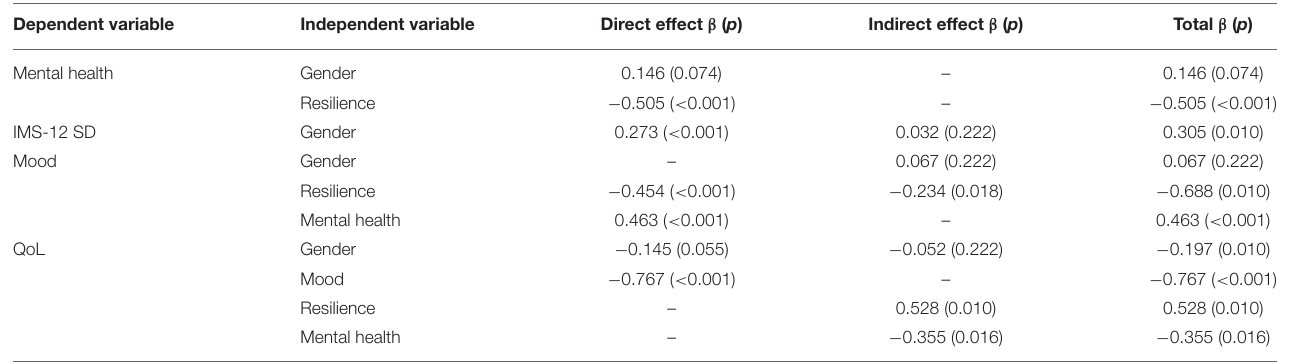
TABLE 3 | Direct, indirect and total effects of the structural equation model